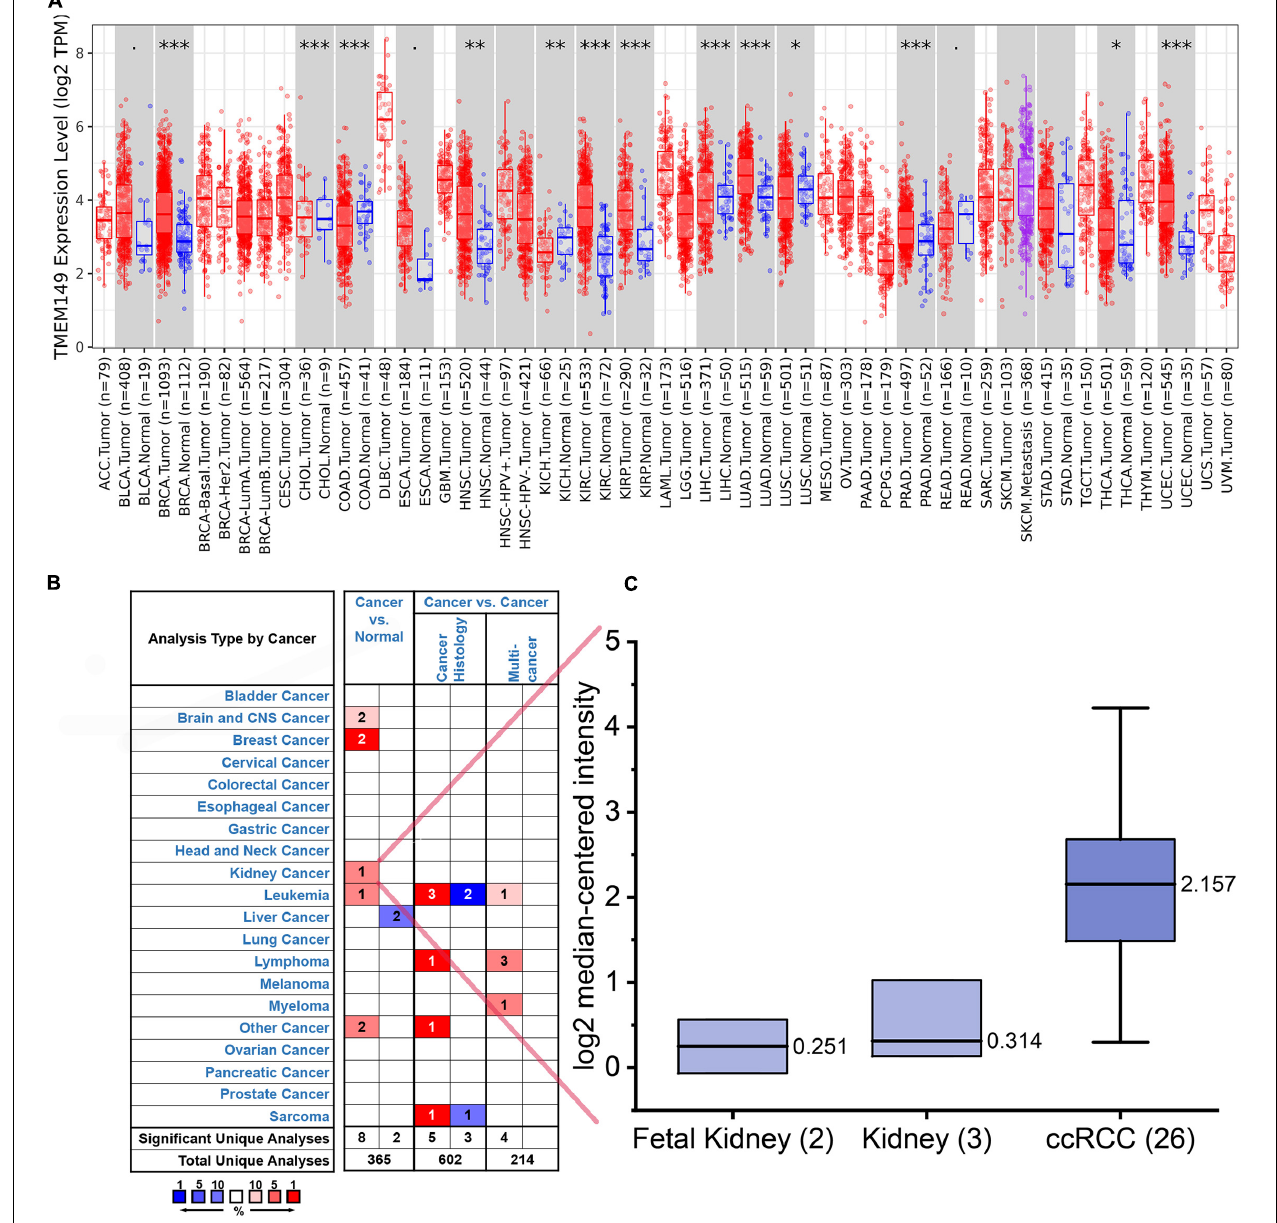
FIGURE 1 | The expression level of IGFLR1 in ccRCC and pan-cancer tissue. (A) The differential expression of IGFLR1 in different cancer and normal tissues using TIMER online platform. The box plot showed the statistical significance of differential expression assessed by Wilcoxon test (n.s.: not significant, * p < 0.05, ** p < 0.01, *** p < 0.001). (B) The Oncomine database showed the high or low expression of IGFLR1 in various cancer tissues compared to normal tissues. The threshold in Oncomine is determined according to the following value: p = 0.0001, fold change = 2, rank = top 10%. (NOTE: An analysis may be counted in more than one cancer type). (C) Comparison of IGFLR1 expression levels in normal and tumor tissues of ccRCC.